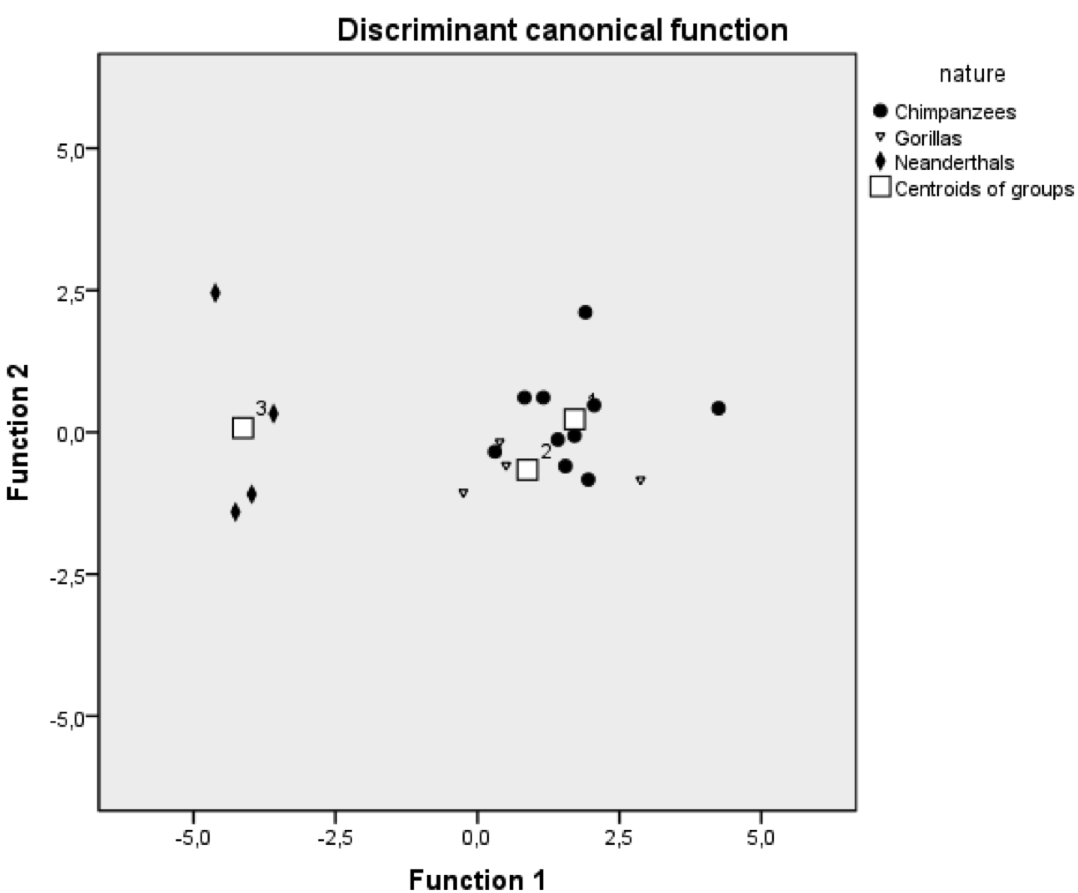
Fig 4. Discriminant analysis. The canonical discriminant analysis plot shows NHP and Neanderthal samples. Group 1 corresponds to the chimpanzee samples, the second to gorillas and the third to